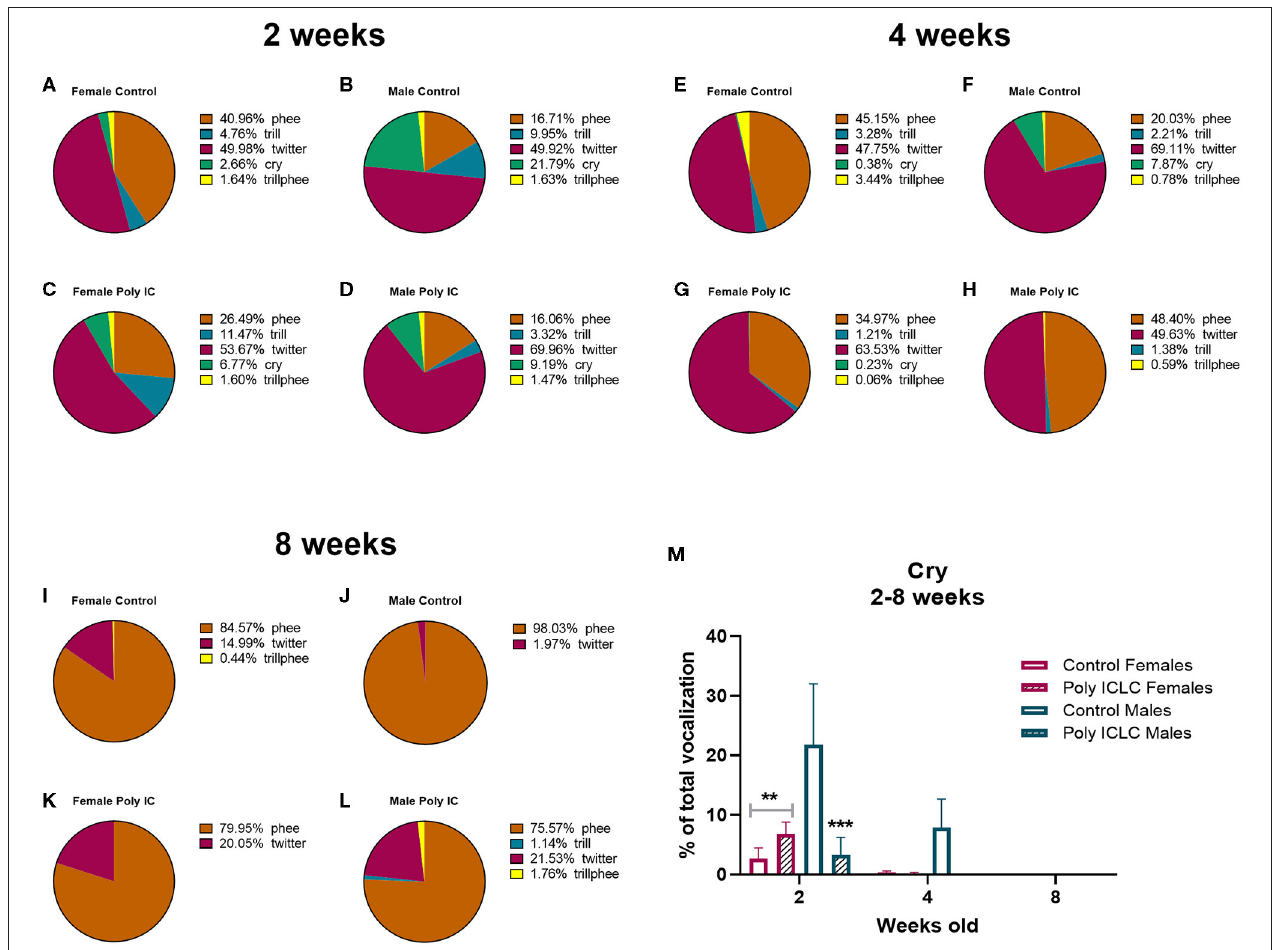
FIGURE 6 | Infants’ repertoire changes during development by sex. Repertoire composition in female and male offspring at 2 (A–D) , 4 (E–H) , and 8 weeks of age (I–L) . (M) Comparison between percentage of cry calls in female and male repertoires throughout development. Data expressed as average percentage of calls from the whole number of calls in the repertoire ± SEM. Data was analyzed by Three-way repeated measures ANOVA with Tukey post-hoc . Control female n = 6, Poly IC females n = 4, Control males n = 2, Poly IC males n = 3. Significant differences are indicated by ** p < 0.01 and *** p < 0.001 vs. Control